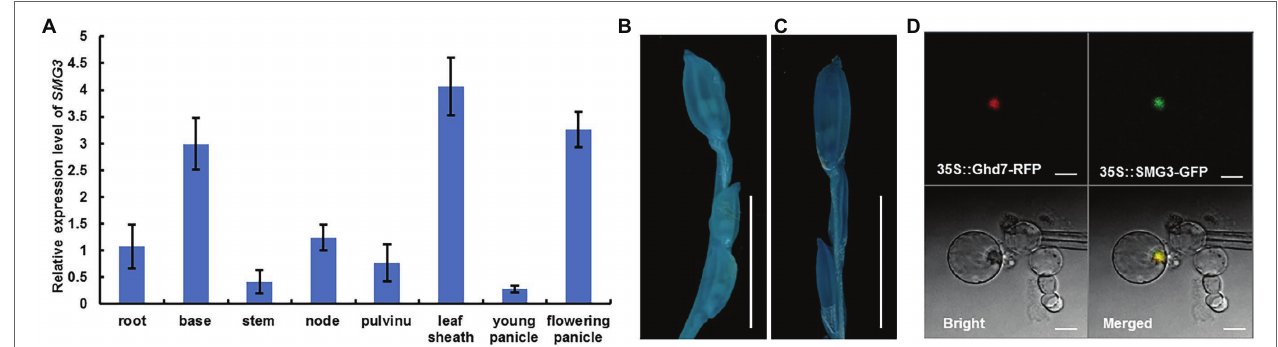
FIGURE 6 | Expression pattern of SMG3 and subcellular localization of SMG3 protein. (A) Relative expression levels of SMG3 in different tissues analyzed by qRT- PCR. Values are means ± SD of three independent experiments. (B,C) Histochemical analysis of GUS activity in caryopsis of 4–5 cm (B) and 13–14 cm (C) long panicle. Scale bars: 1 cm. (D) Subcellular localization of the SMG3 protein by GFP assays. The subcellular localization was performed with red fluorescent protein (RFP) as a nuclear marker. The 35S::SMG3-GFP and 35S::Ghd7-RFP were co-expressed in rice protoplasts. Scale bar: 10 μ